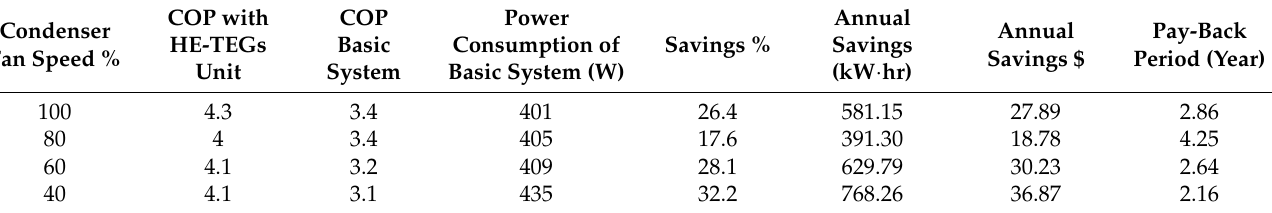
Table 4. Economic analysis of using HE-TEGs unit